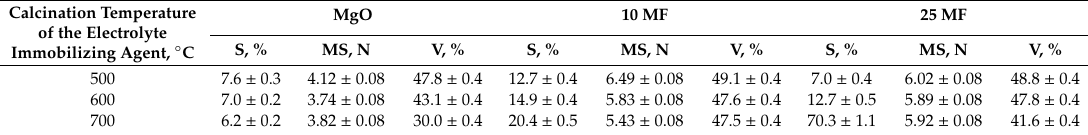
Table 2. Results of the measurements of dimensional stability ( S ), mechanical strength ( MS ), and the unfilled spaces ( V ) in the pellets, when using MgO, 10 MF, and 25 MF as immobilizing agents. The immobilizing agent content in a pellet was 40 wt.%.